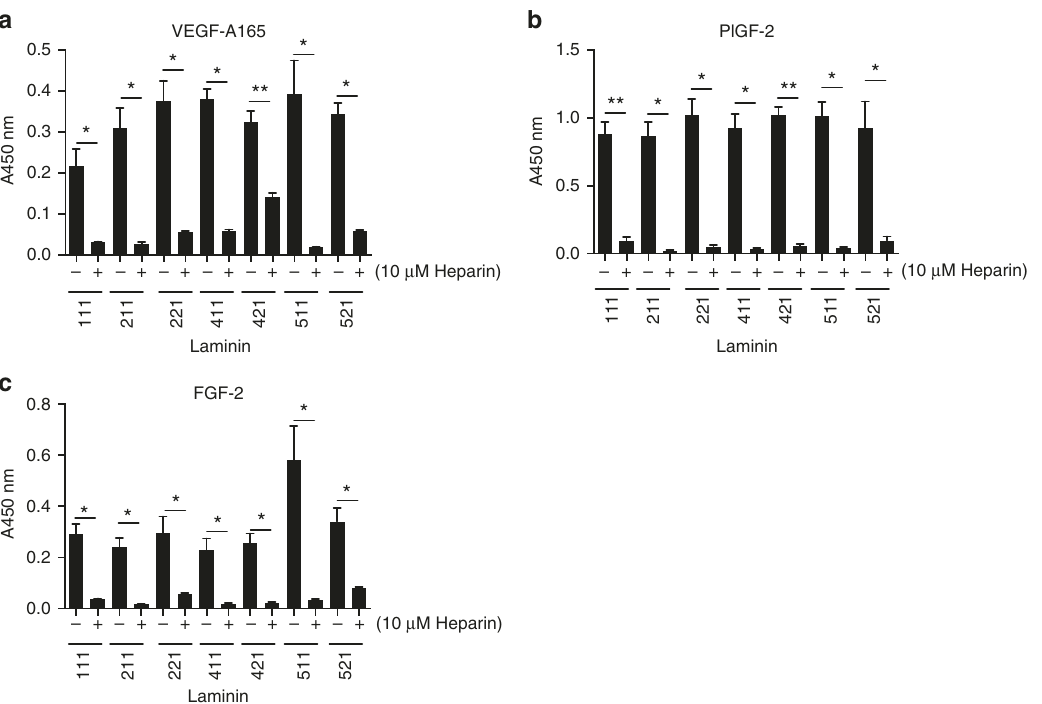
Fig. 2 Excess heparin inhibits GF – laminin binding. Inhibition of GF-binding to laminin ( – 111, – 211, – 221, – 411, – 421, – 511, and – 521) by excess heparin. ELISA plates were coated with 10 µ g/mL laminin and further incubated with 1 μ g/mL a VEGF-A165, b PlGF-2, or c FGF-2 solution in the absence or presence of excess (10 μ M) heparin. Bound GFs were detected using a speci fi c antibody for each GF ( n = 4, mean ± SEM). Statistical analyses were performed using the Mann – Whitney U test by comparing the signals with and without heparin. * p < 0.05, ** p < 0.01. Two experimental